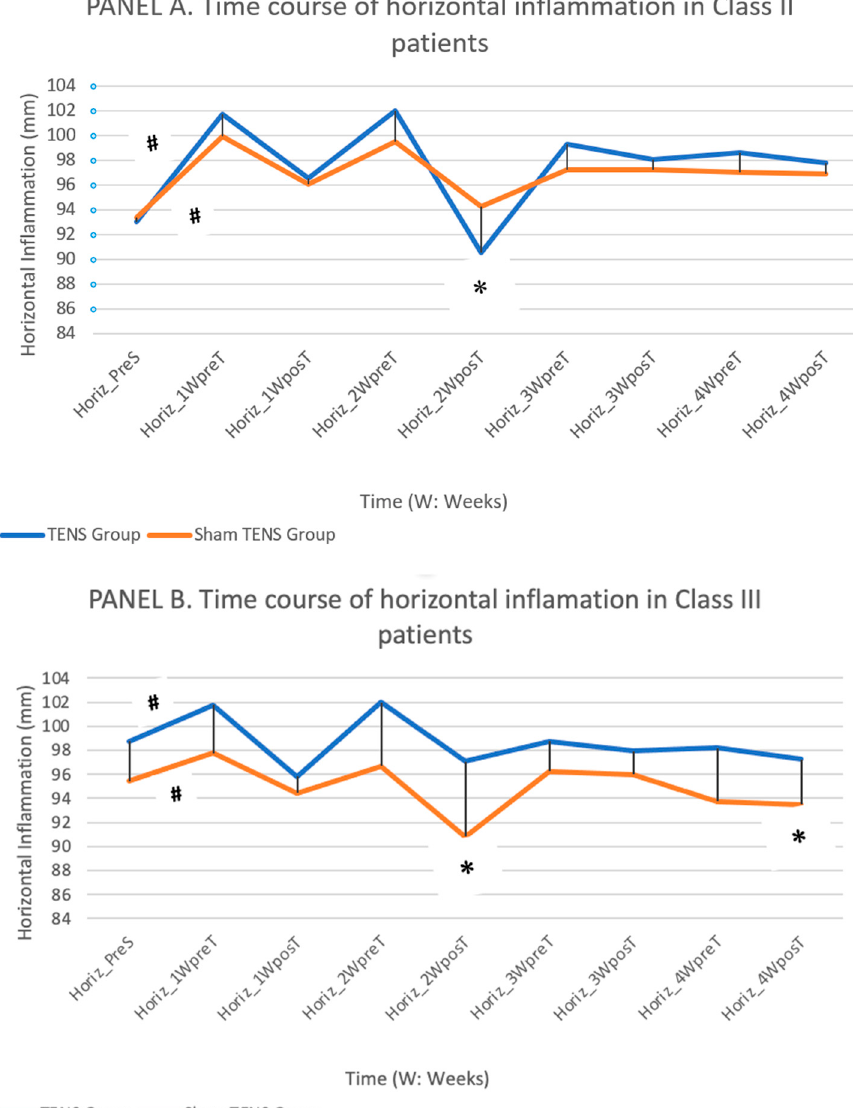
Figure 5. Depicts the time course of horizontal inflammation values in the TENS and sham-TENS groups of class II patients ( A ) and class III patients ( B ) over the study period. ( # significant differ- ences ( p < 0.05) between different time points in the same group, * significant differences ( p < 0.05) between